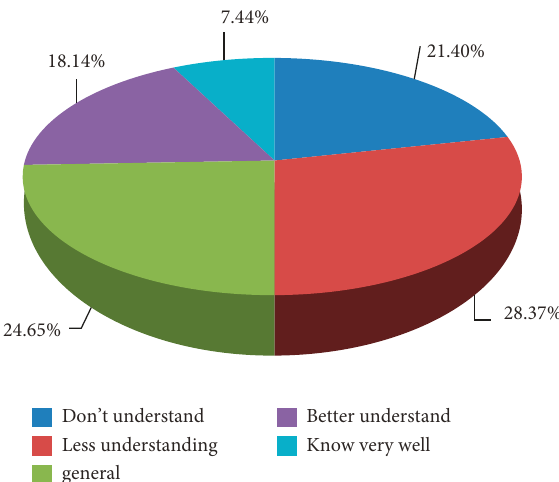
Figure 6: Respondents’ understanding of garbage classification standards.